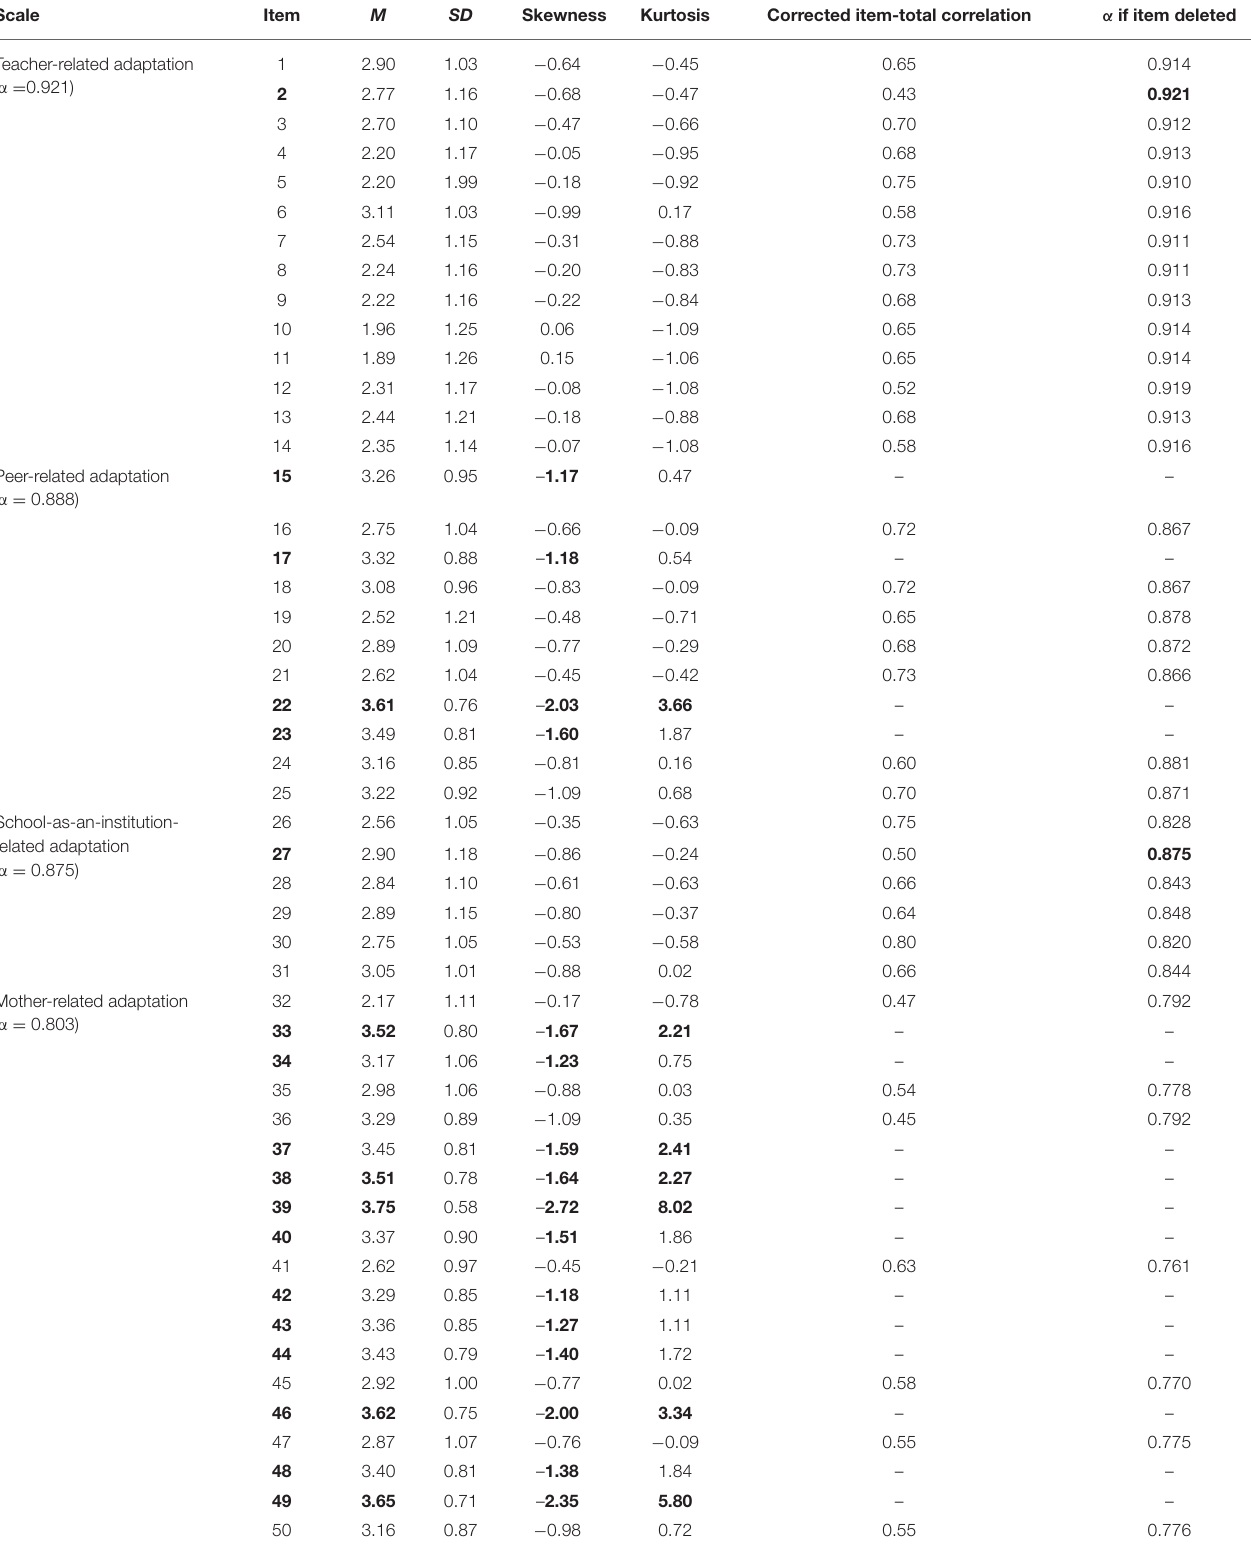
TABLE 1 | Descriptives about optimum difficulty and internally consistency at item level. Scale